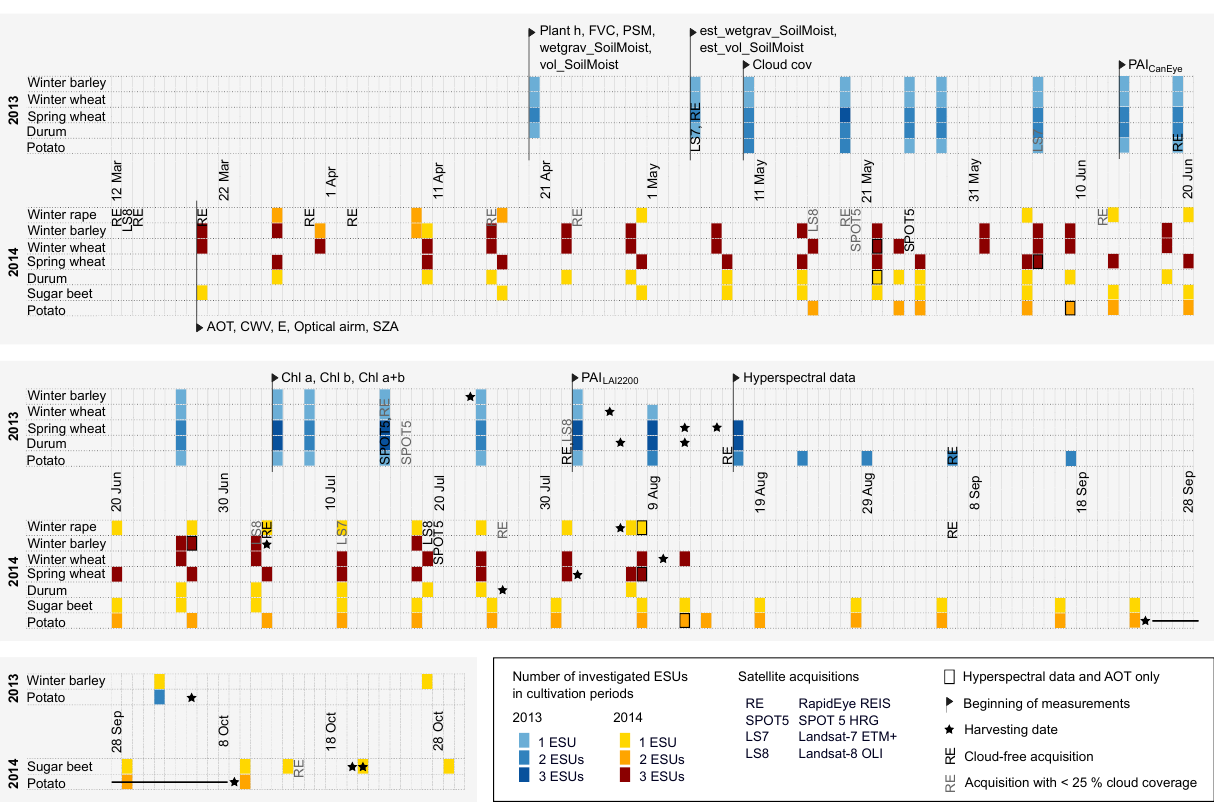
Figure 3. Overview of days of field work carried out on the Gebesee test site to ascertain the phenological evolution of various crop types on elementary sampling units (ESUs) throughout the cultivation periods 2013 (yellow to red) and 2014 (light to dark blue), and availability of space-borne images with < 25% of the test site covered with clouds. The measurement start varied between the parameters investigated in 2013, while complete datasets are available for the entire cultivation period in